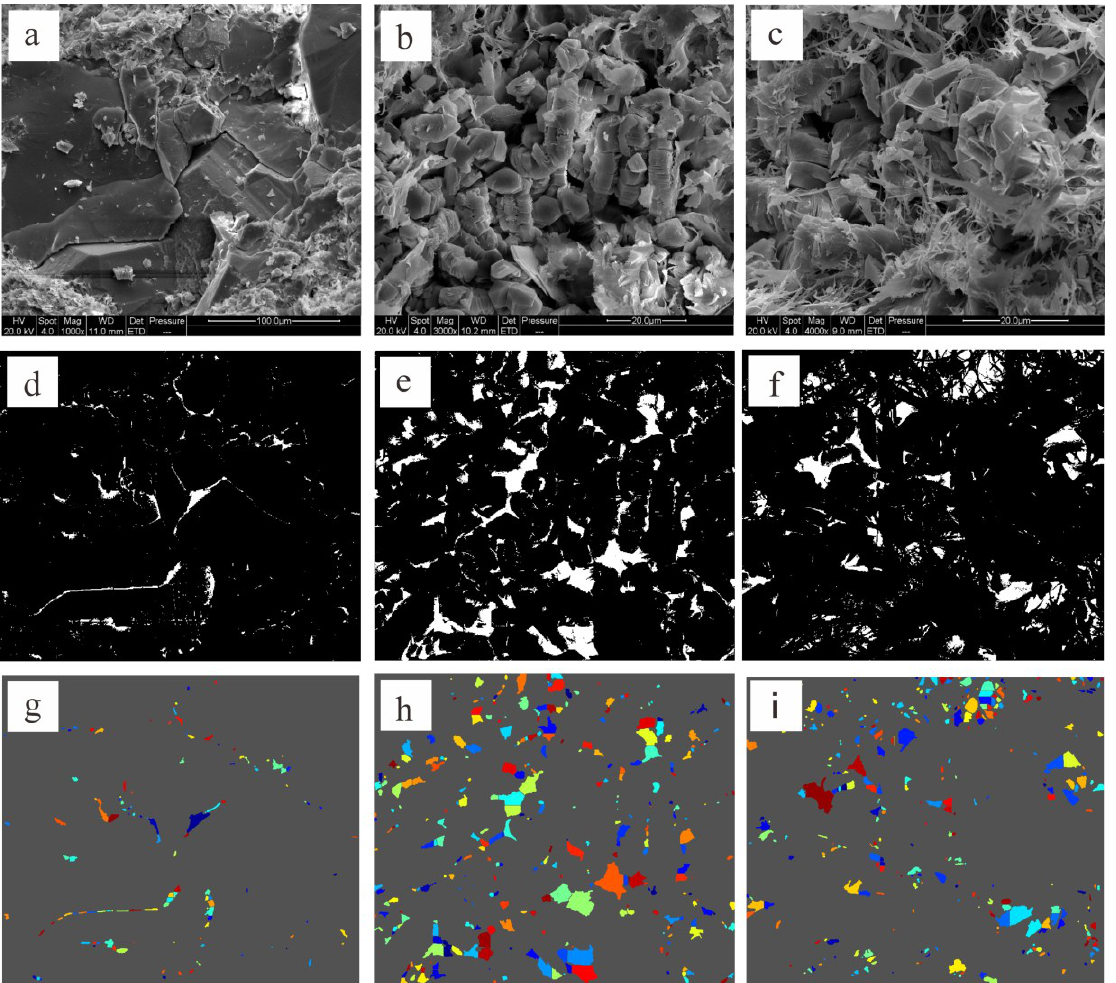
Figure 6. SEM image, binary image, and pore distribution image of pore throat in the He8 Section. ( a ) SEM image of intergranular pores of overgrowth quartz; ( b ) SEM image of kaolinite intercrystalline; ( c ) SEM image of illite intercrystalline; ( d ) binary image of intergranular pores of overgrowth quartz; ( e ) binary image of kaolinite intercrystalline; ( f ) binary image of illite intercrystalline; ( g ) pore throat distribution of intergranular pores of overgrowth quartz; ( h ) pore throat distribution of kaolinite intercrystalline; ( i ) pore throat distribution of illite